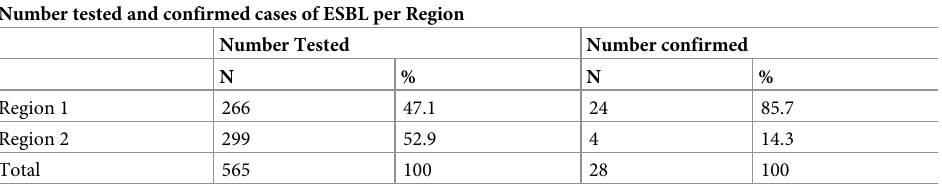
Table 2. Distribution of ESBL producing Enterobacteriaceae carriage among food handlers in West Region (Region1 and Region 2). Number tested and confirmed cases of ESBL per